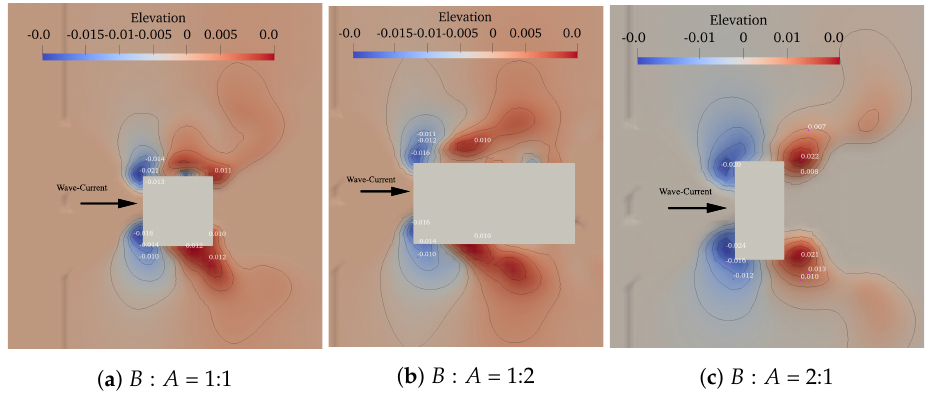
Figure 6. Contours of bed topography for combined wave − current parameter U cw of 0.4 and KC = 3.9 for varying aspect ratios of the rectangular pile. The side (B) of the rectangular pile is 0.18 m and the period (T) of the wave is 4.5 s. Duration of the simulation run is 3600 s.